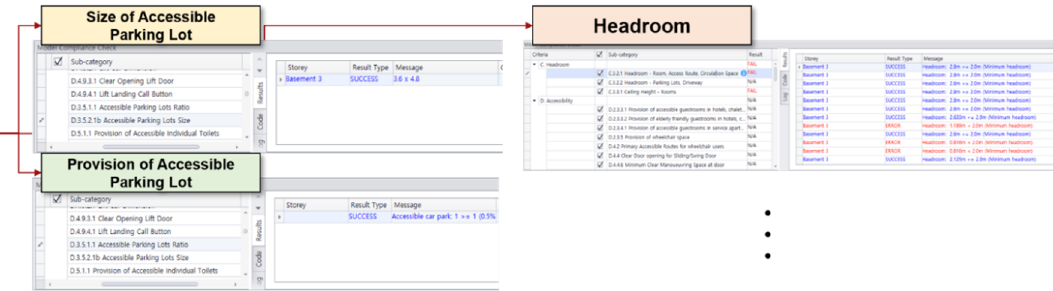
Figure 10. Review of BIM-based parking lot licensing laws (SBim Assess) for the licensing (continue).